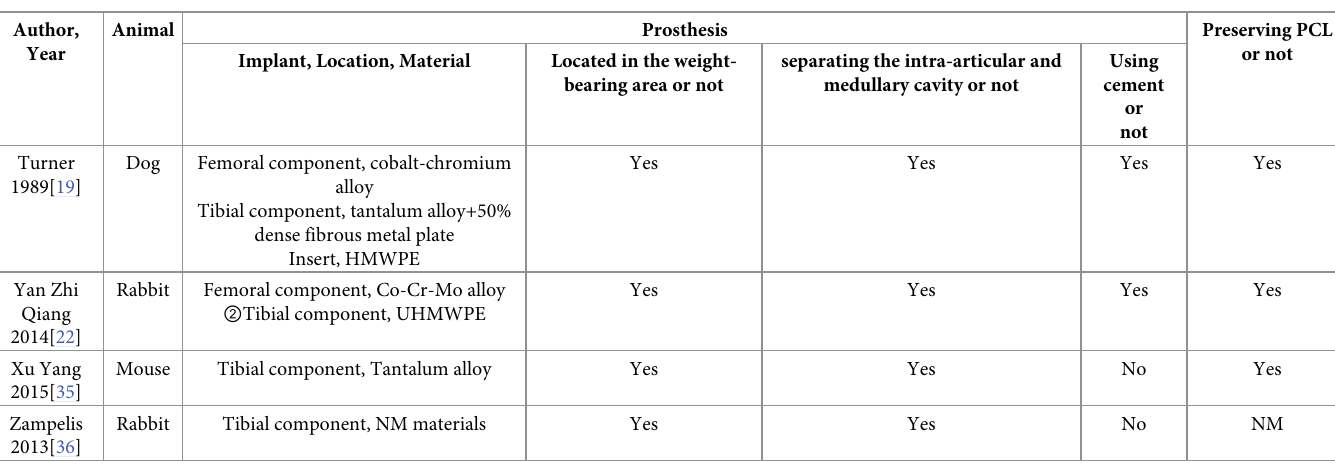
Table 2. Non-infective animal